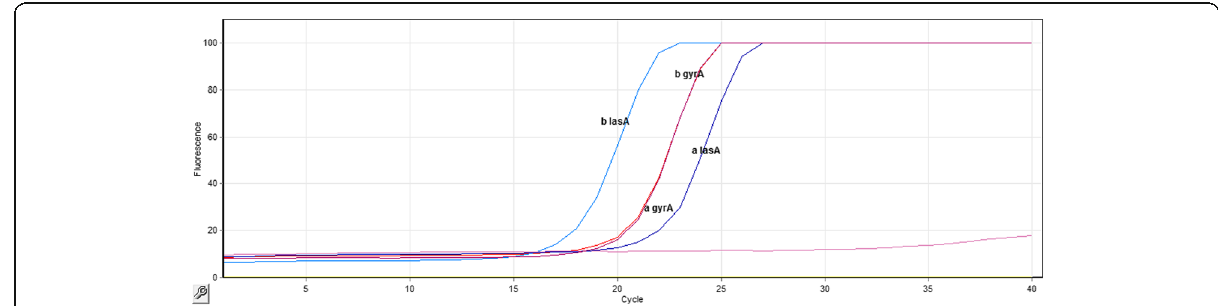
Fig. 2 lasA gene amplification curve using Real-time RT-PCR technique: As outlined in the figure, the Ct level of the lasA gene was different before and after treatment (Ct before treatment = 12.64 and Ct after treatment = 10.38). However, there was no change in the Ct level of the gyrA gene before and after treatment (Ct before treatment= 14.56 and Ct after treatment= 14.06). Therefore, the amount of the lasA gene expression changed after treatment, while the gyrA gene expression had no change before and after